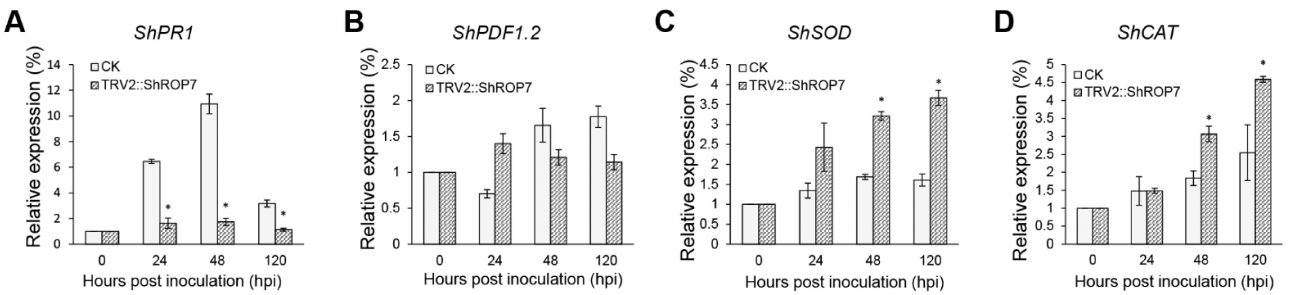
Figure 6. Real-time quantitative PCR (RT-qPCR) analyses of expression of ShPR1 ( A ), ShPDF1.2 ( B ), ShSOD ( C ) and ShCAT ( D ) genes in CK (LA1777) and TRV2::ShROP7 plants inoculated with On -LZ. Error bars represent the variations among three independent replicates. The asterisk ( * ) indicates a significant difference compared with 0 hpi ( p <